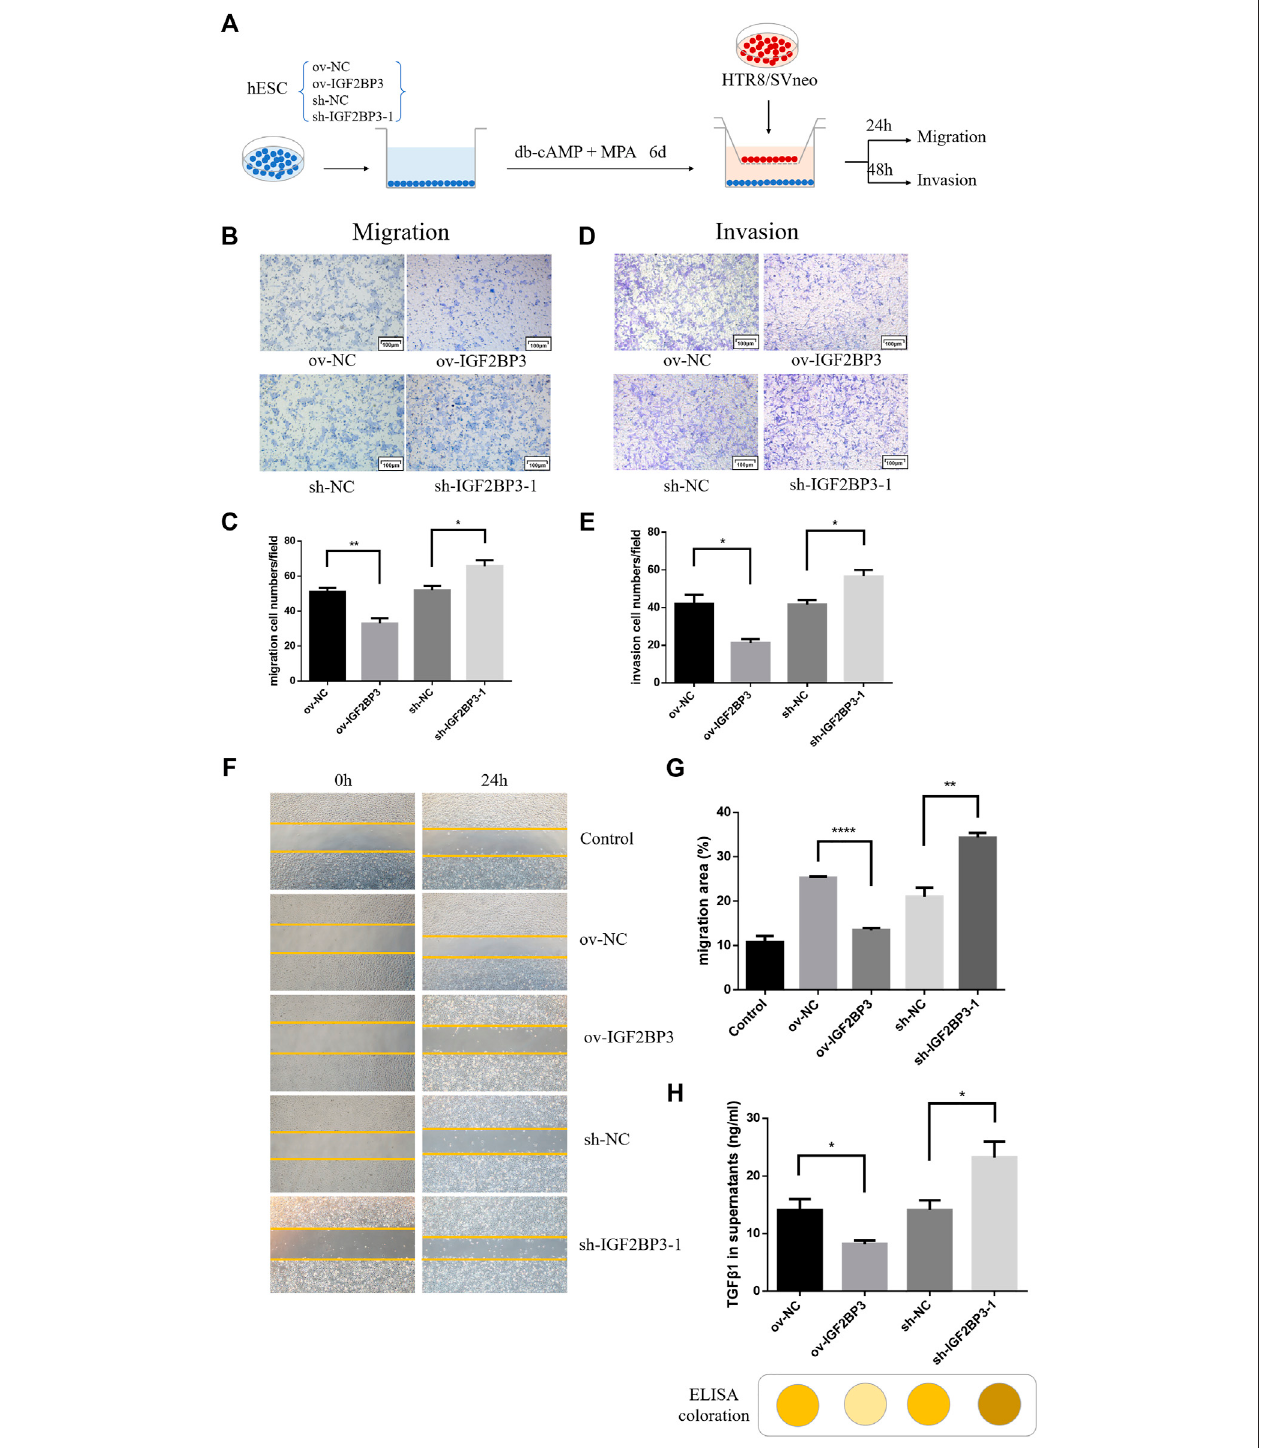
FIGURE 4 | IGF2BP3 in maternal – fetal interface cells cross talk (A) schematic diagram of the process of co-culture experiments, (B) transwell migration of HTR8/ SVneo cells in co-culture with IGF2BP3-transfected HESCs, (C) quanti fi cation statistics of the results of cell migration, (D) transwell invasion of HTR8/SVneo cells in co- culture with IGF2BP3-transfected HESCs (E) Quanti fi cation statistics of the results of cell invasion, (F) scratch wound-healing by different decidual cell culture supernatants for culturing trophoblasts, (G) HTR8/SVneo cells migration quanti fi ed by wound-healing index. Migration area (%) = (A0 — An)/A0 × 100, and (H) ELISA measurement of the expression levels of TGF- β 1 in decidual cell culture supernatants of sh-IGF2BP3, ov-IGF2BP3, and their respective control groups. Each experiment was independently performed three times. * p < 0.05, ** p < 0.01, *** p < 0.001, and **** p < 0.0001 vs. control.